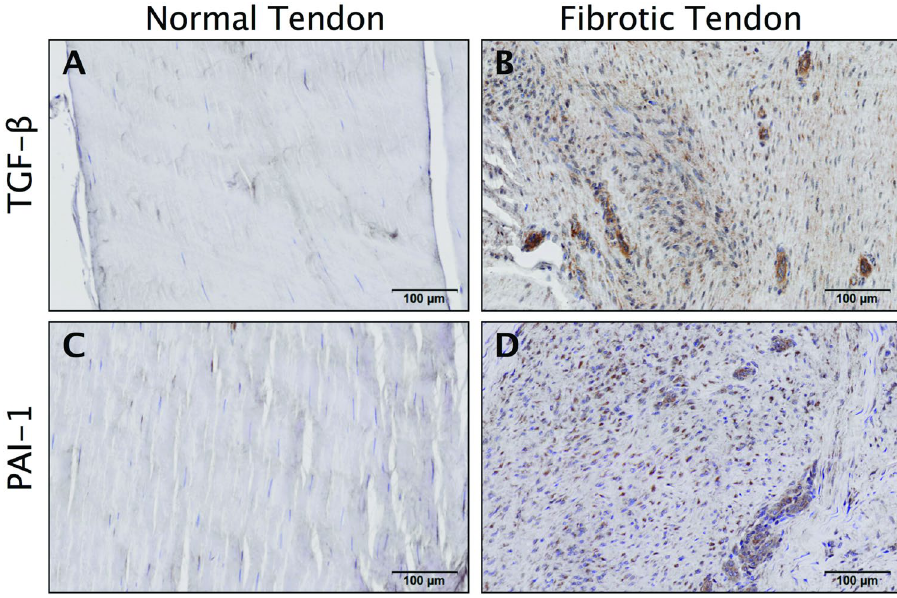
Figure 1. TGF- β 1 and PAI-1 are ubiquitous in fibrotic human tendon tissue. Immunohistochemical (IHC) staining of normal human tendon ( A and C ) and fibrotic Dupuytren’s contracture tissue ( B and D ) against TGF- β 1 and PAI-1. Brown staining in B and D indicates increased TGF- β 1 and PAI-1,